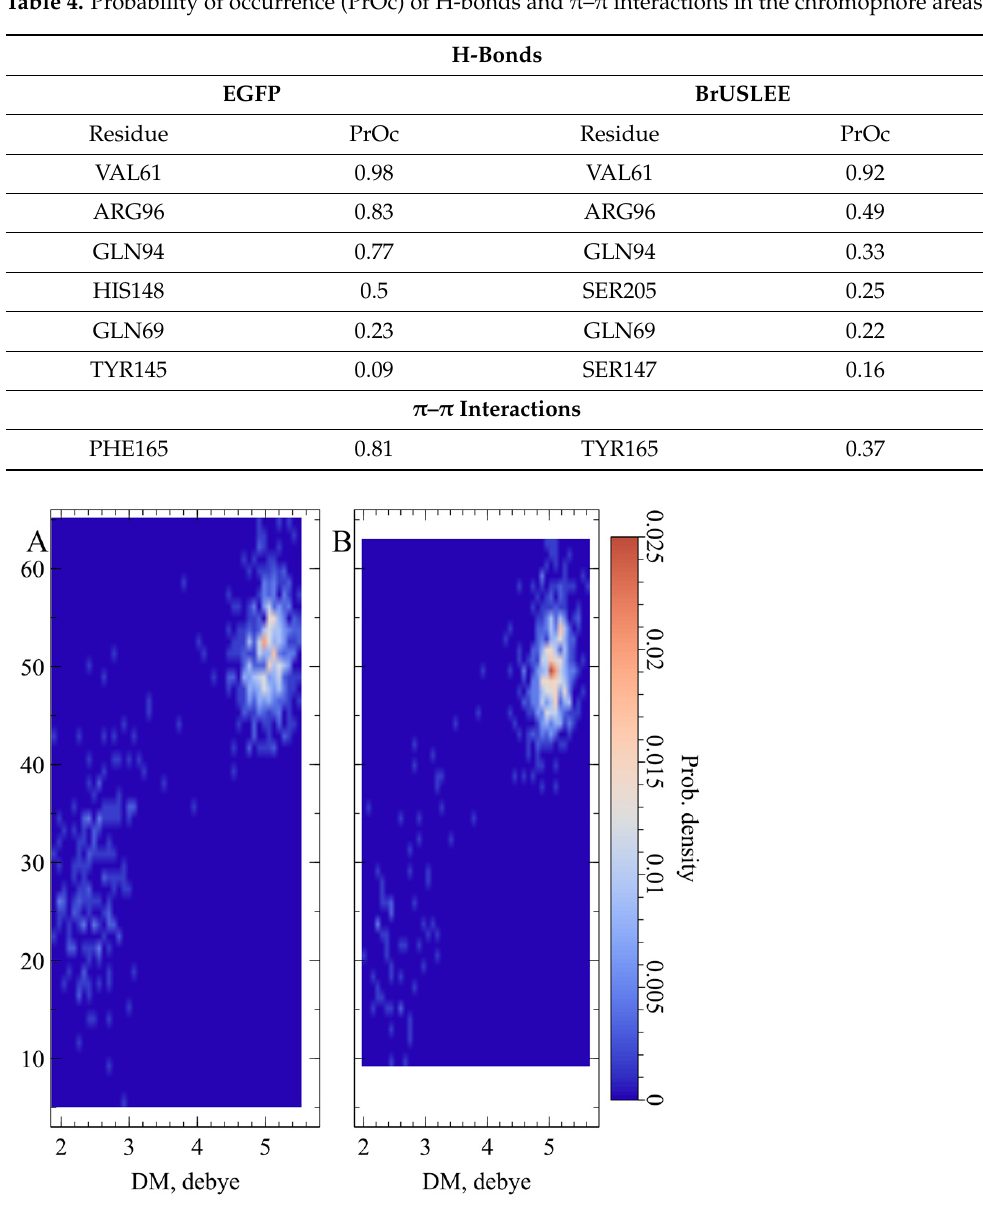
Figure 5. MD-derived two-dimensional distribution of the modulus of the chromophore dipole mo- ment (DM) ( X -axis) vs. the angle between the CG2-CZ vector in the phenolic ring of the chromophore and the DM vector ( Y -axis) in the EGFP ( A ) and BrUSLEE ( B ). The values of the probability density of the occurrence of MD states are given according to the color scale (on the